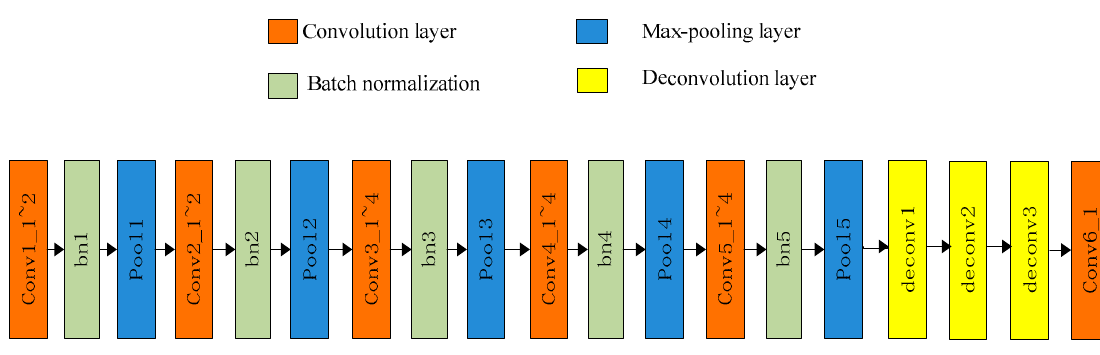
Figure 1. Architecture of the deconvolution VGG network (De-VGG )network.